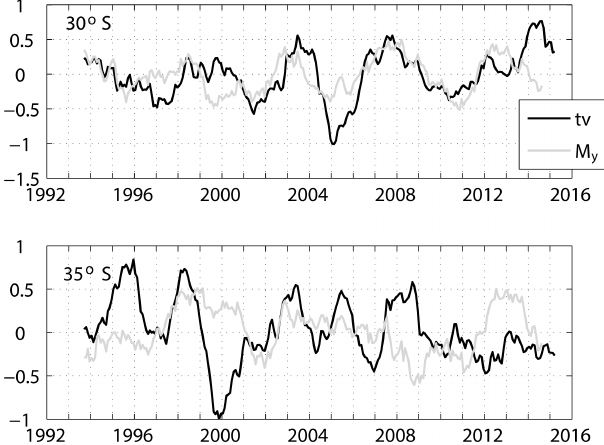
Figure 10. Zonally integrated normalized anomalies M y (gray) and meridional transport (tv, black) at 30 and 35 ◦ S. Both the time series are smoothed using an 18-month running mean